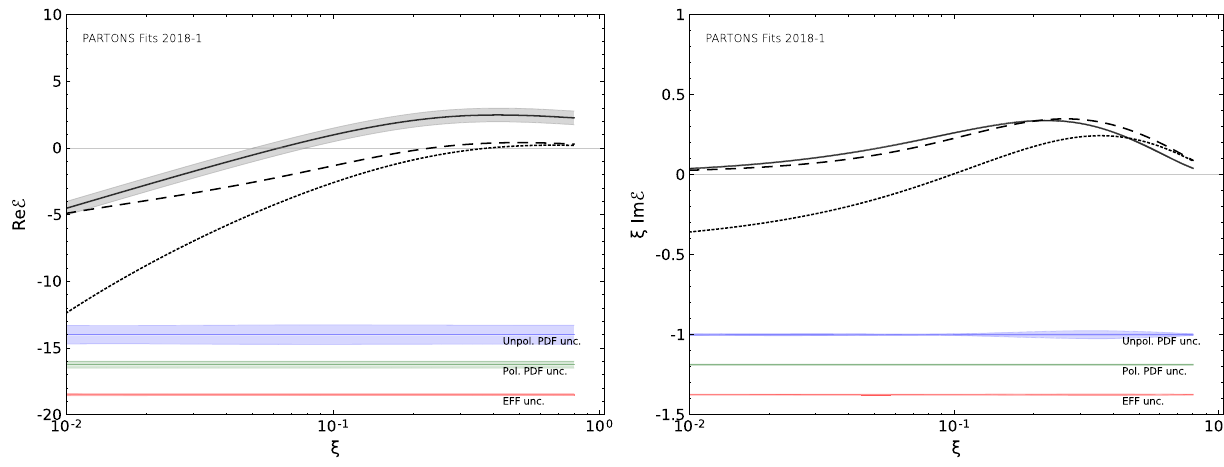
Fig. 13 Real (left) and imaginary (right) parts of the CFF E obtained in this work as a function of ξ at t = − 0 . 3 GeV 2 and Q 2 = 2 GeV 2 . For further description see Fig. 6